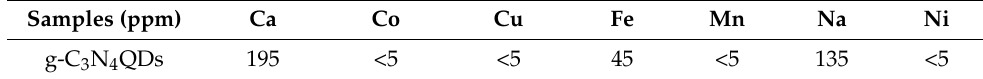
Table 1. Inductively coupled plasma (ICP) analysis data of g-C 3 N 4 QDs. Samples